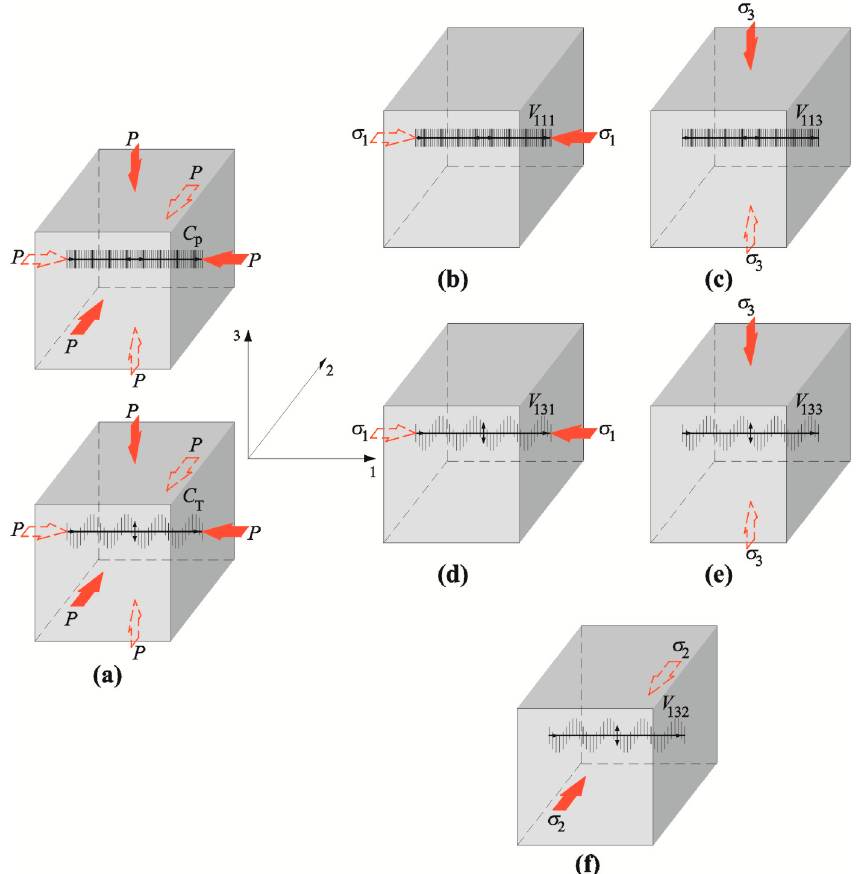
Figure 1. Identification of velocity of ultrasonic waves in isotropic material: ( a ) hydrostatic compression by pressure P, ( b ) longitudinal wave under stress σ 1 , ( c ) transverse wave under stress σ 3 , polarized in planes 1–3 ( d ) transverse plane under stress σ 1 , polarized in planes 1–3, ( e ) transverse plane under stress σ 3, polarized in planes 1–3, ( f ) longitudinal wave under stress σ 2, polarized in planes 1–3.